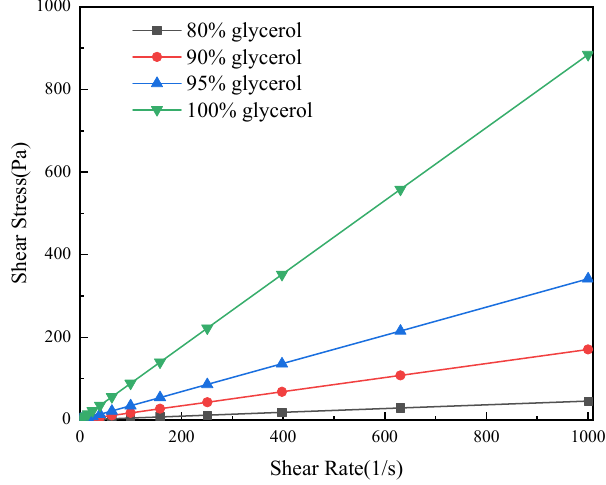
Figure 1. Rheological plots of glycerol aqueous solutions with different concentrations.